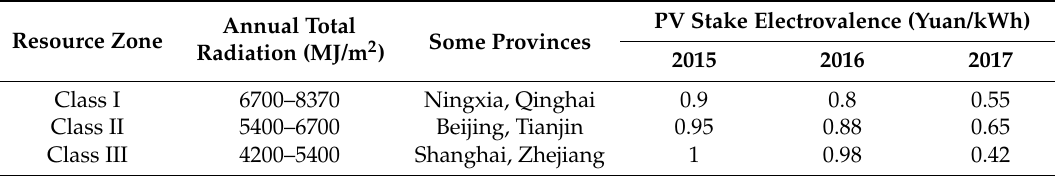
Table 1. The Photovoltaic resource zones and stake electrovalence in